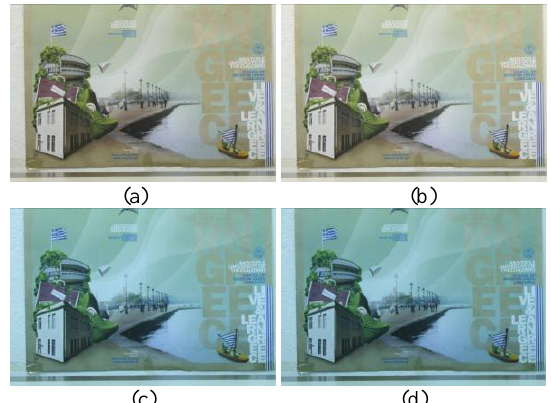
Figure 3.1 shows different test snapshots with different criteria.